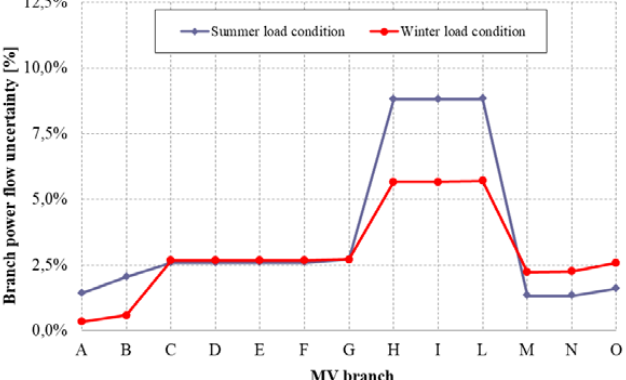
Figure 9. Branch power flow uncertainty with seven PMs located in the Vittorio Emanuele feeder: comparison between summer and winter load conditions.